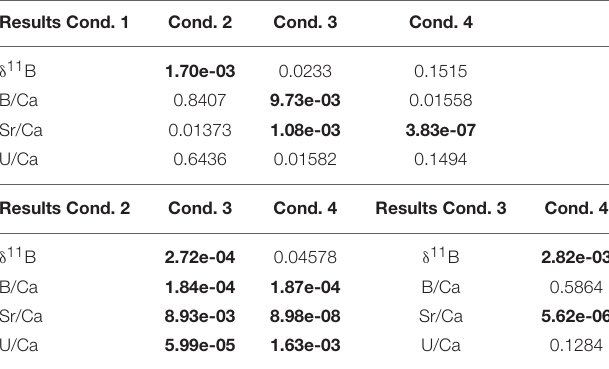
TABLE 5 | Summary of Student’s T -test results ( p -values) between each experimental condition. Results Cond.